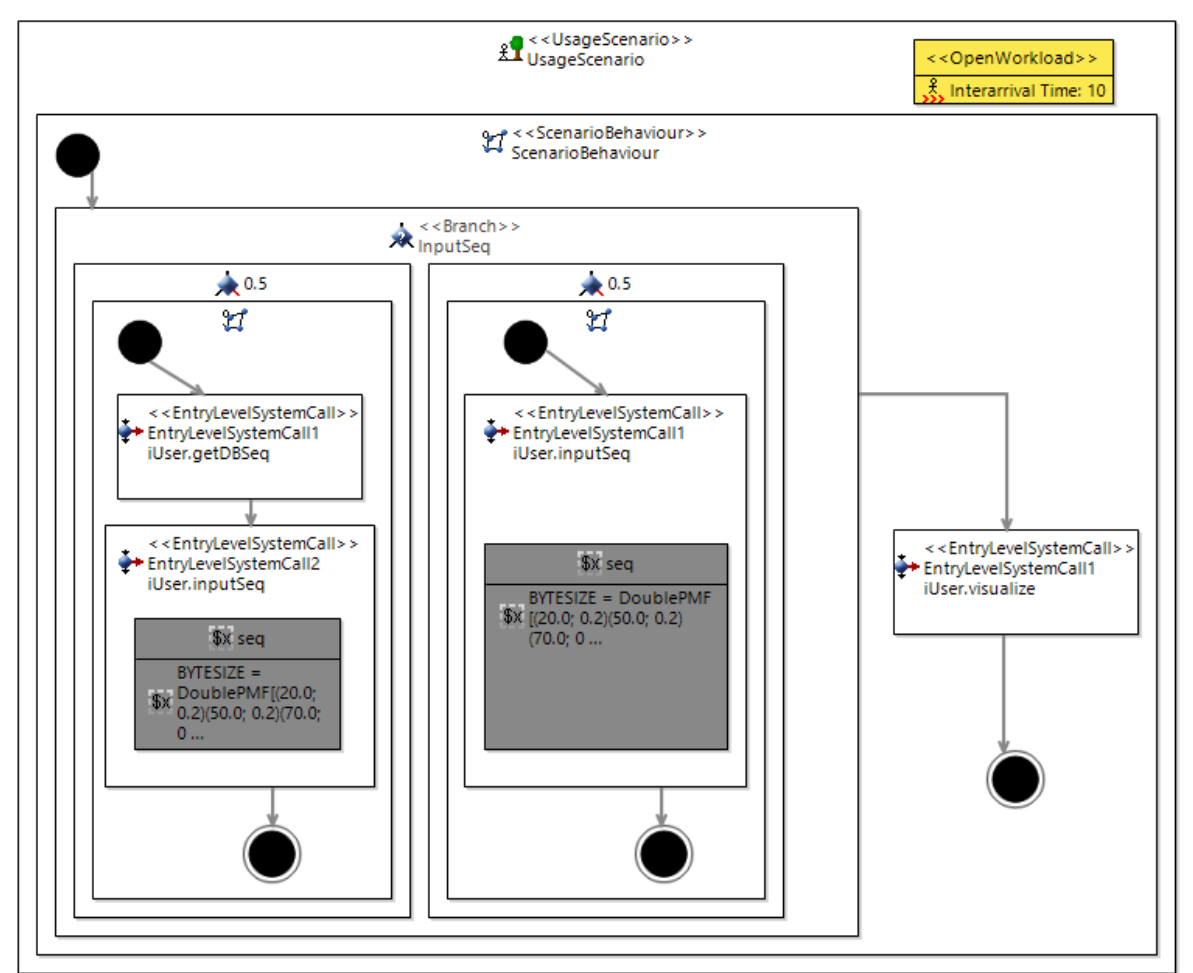
Figure 8. Usage model diagram for the phylogenetic analysis module.